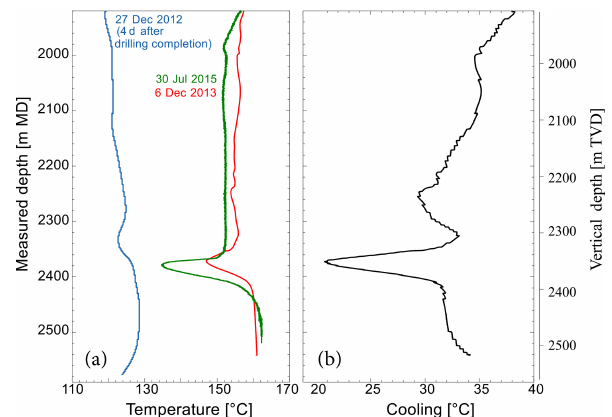
Figure 14. (a) Variation of temperature ( ◦ C) as a function of mea- sured depth (MD) or vertical depth (TVD) estimated from the tem- perature log acquired in 2015 in GRT-1 (green curve), plotted along with the temperature log acquired in 2013 (red curve). The temper- ature log acquired 4d after drilling completion (blue curve) enables us to estimate the temperature at the borehole wall during drilling. (b) Estimation of the difference between the wellbore temperature and the borehole wall temperature after completion (cid:49)t used in the evaluation of the thermal stress